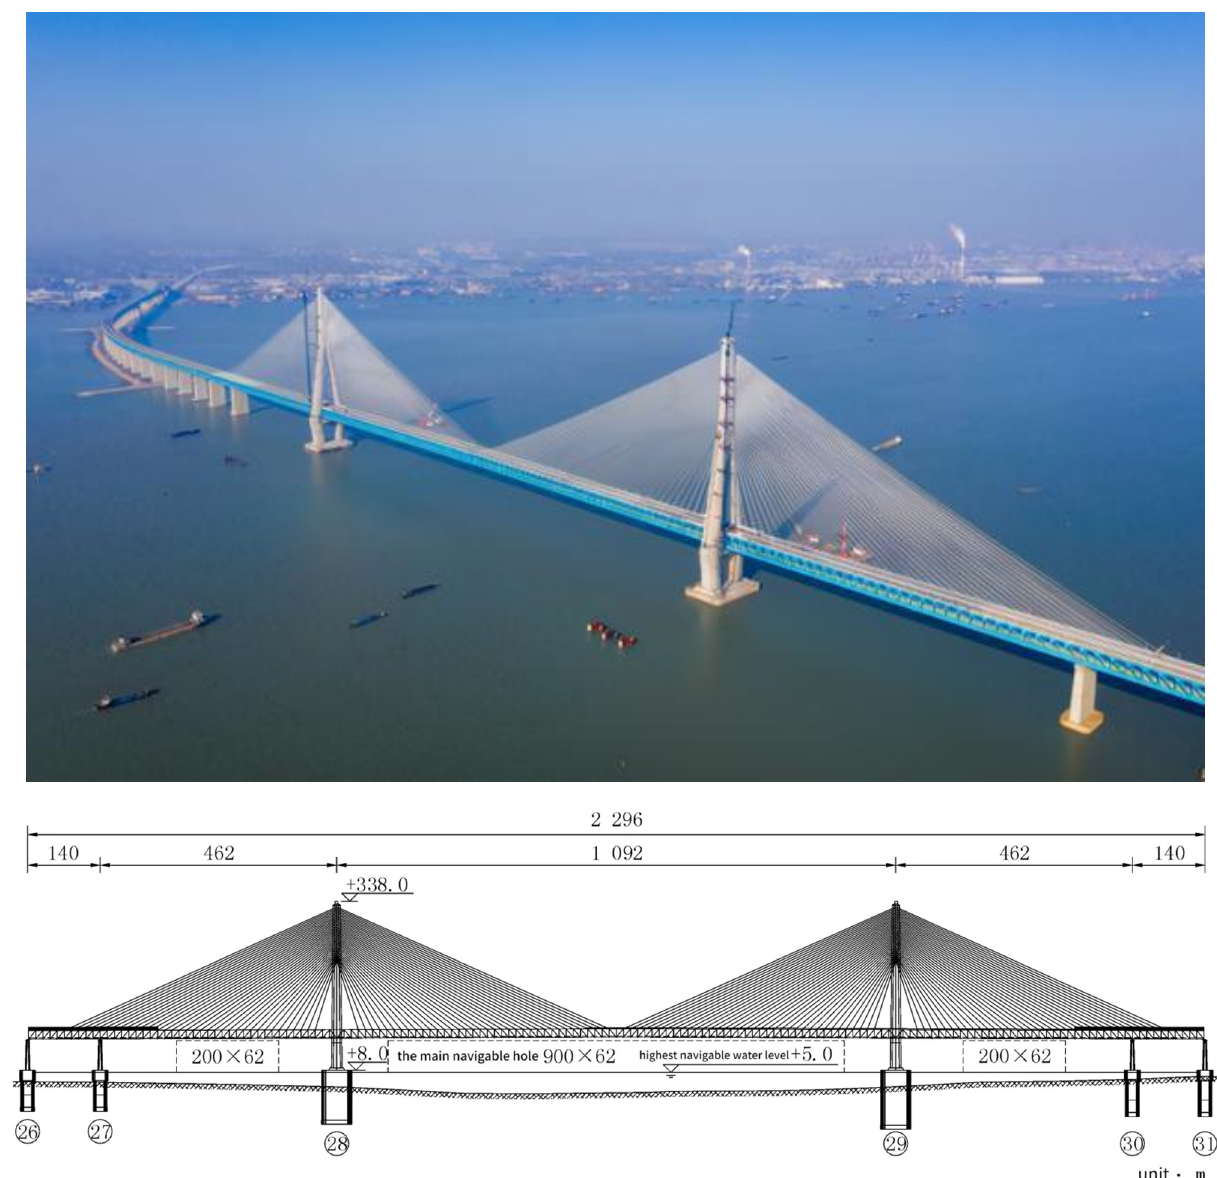
Figure 6. Plan of the main navigable opening of Shanghai–Nantong Railway Yangtze River Bridge.